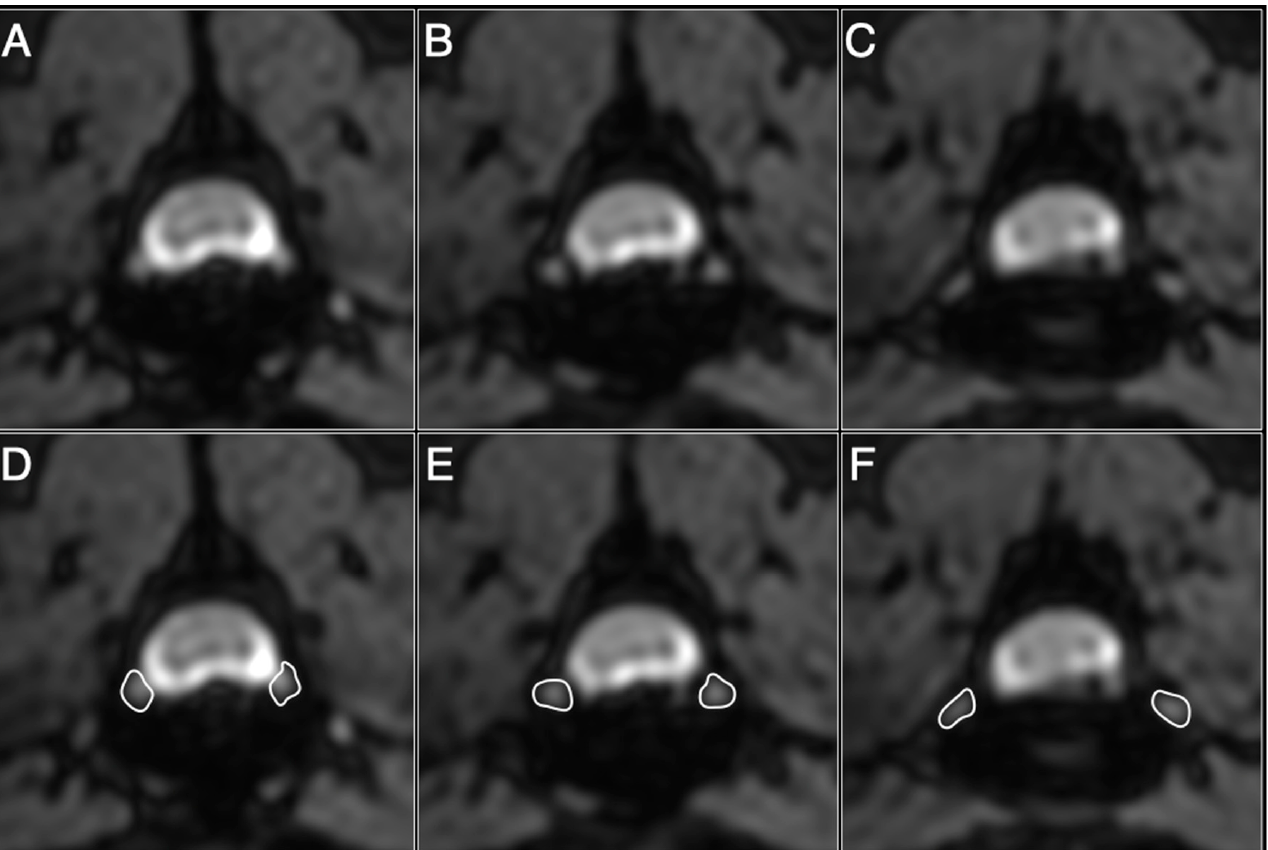
Figure 1. Sequential image slices of dorsal root ganglion (DRG) in control dog (Dog#8). Nerve roots emerge from the spinal cord ( A ), form a DRG that passes caudally ( B ), and enter the intervertebral foramen ( C ). All DRG were manually segmented by tracing the border (white lines) and the cross-sectional area of the DRG was calculated from the number of pixels contained within the traced contour ( D – F ).